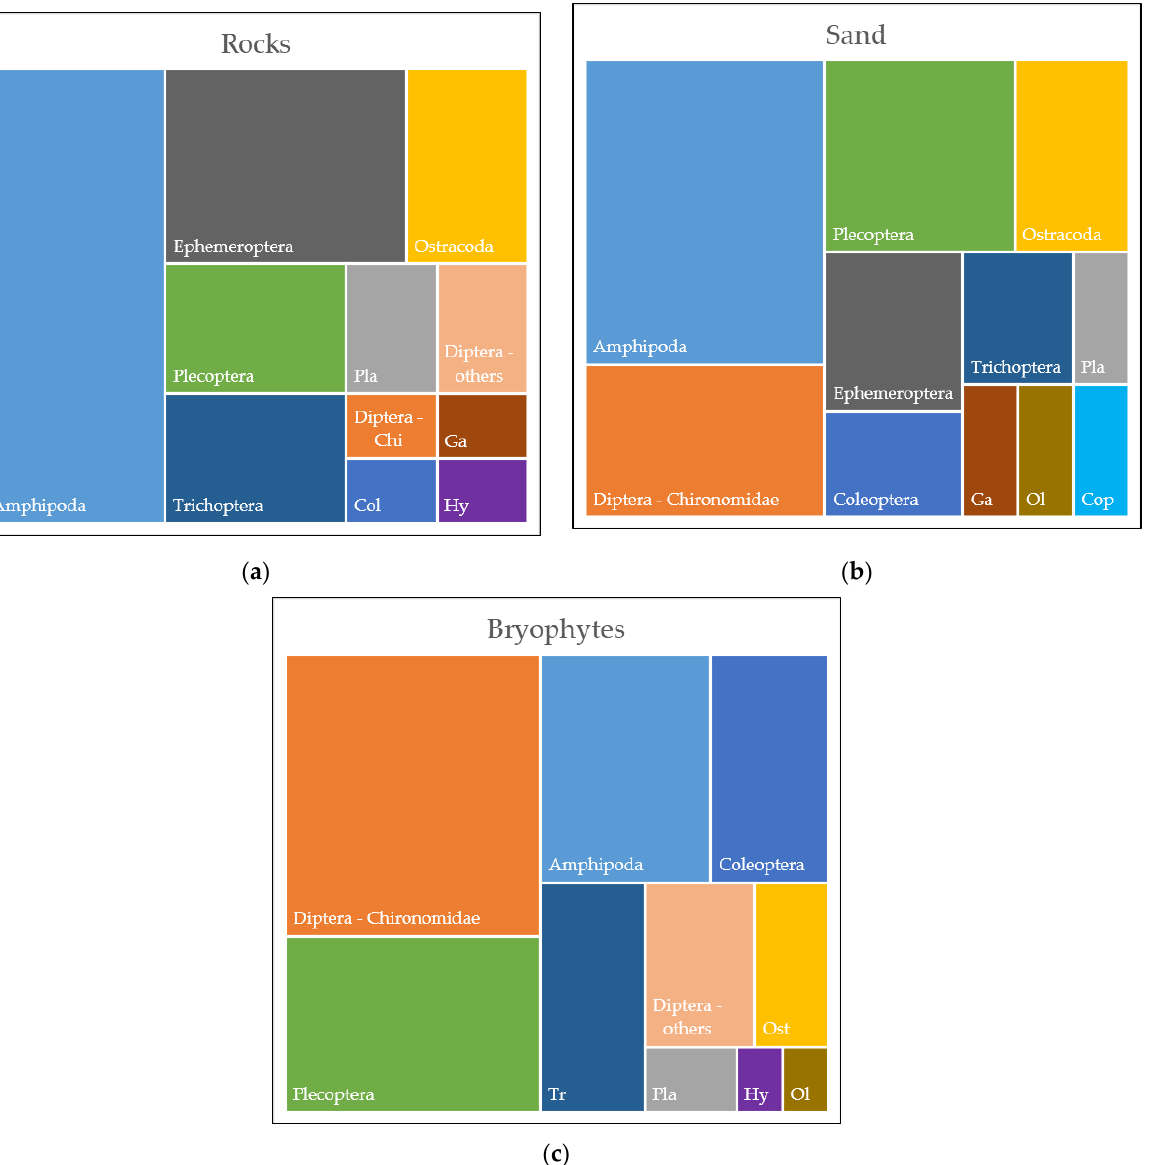
Figure 4. Treemaps showing the crenic groups that preferred the rocky substratum ( a ), sand ( b ), and bryophytes ( c ) according to the standardized selection index (larger rectangles depict taxa with higher percentages of springs where different substrates were preferred) (Chi — Chironomidae;